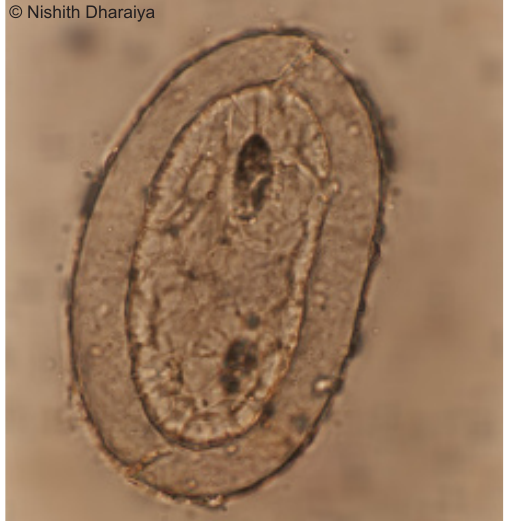
Image 10. Cross section of hair of Small Indian Civet